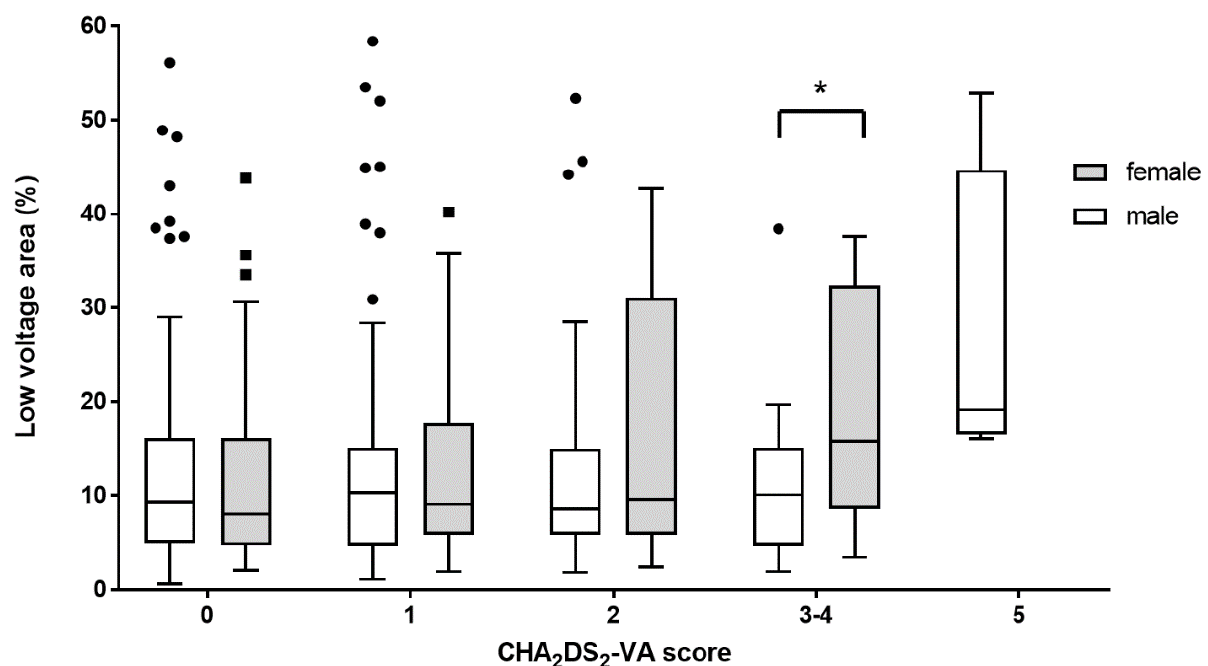
Figure 2. Difference in the proportion of left atrial low voltage area between males and females according to CHA 2 DS 2 -VA score. The proportion of left atrial low voltage area was similar between males and females in the patients with CHA 2 DS 2 -VA scores of 0 to 2. There was a significant difference in the proportion of low voltage area (LVA) between male and female in the patients with CHA 2 DS 2 -VA scores of 3 or 4 (10.1 (4.7–15.1)% vs. 15.8 (9.2–32.1)%; p = 0.027). Within each box, horizontal lines denote the median value; boxes extend from the first quartile to the third quartile value of each group. The vertical extended lines denote the adjacent values. The dots denote values outside the range of the adjacent values. * p = 0.027.